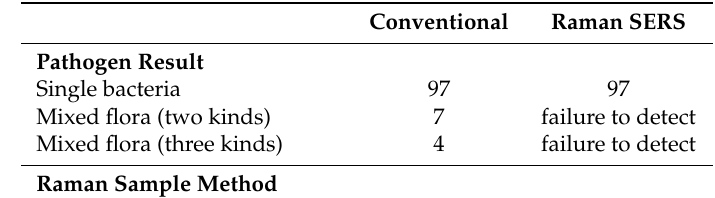
Table 1. Results of conventional culture and Raman surface-enhanced Raman spectroscopy (SERS) from 108 urinary tract patients.